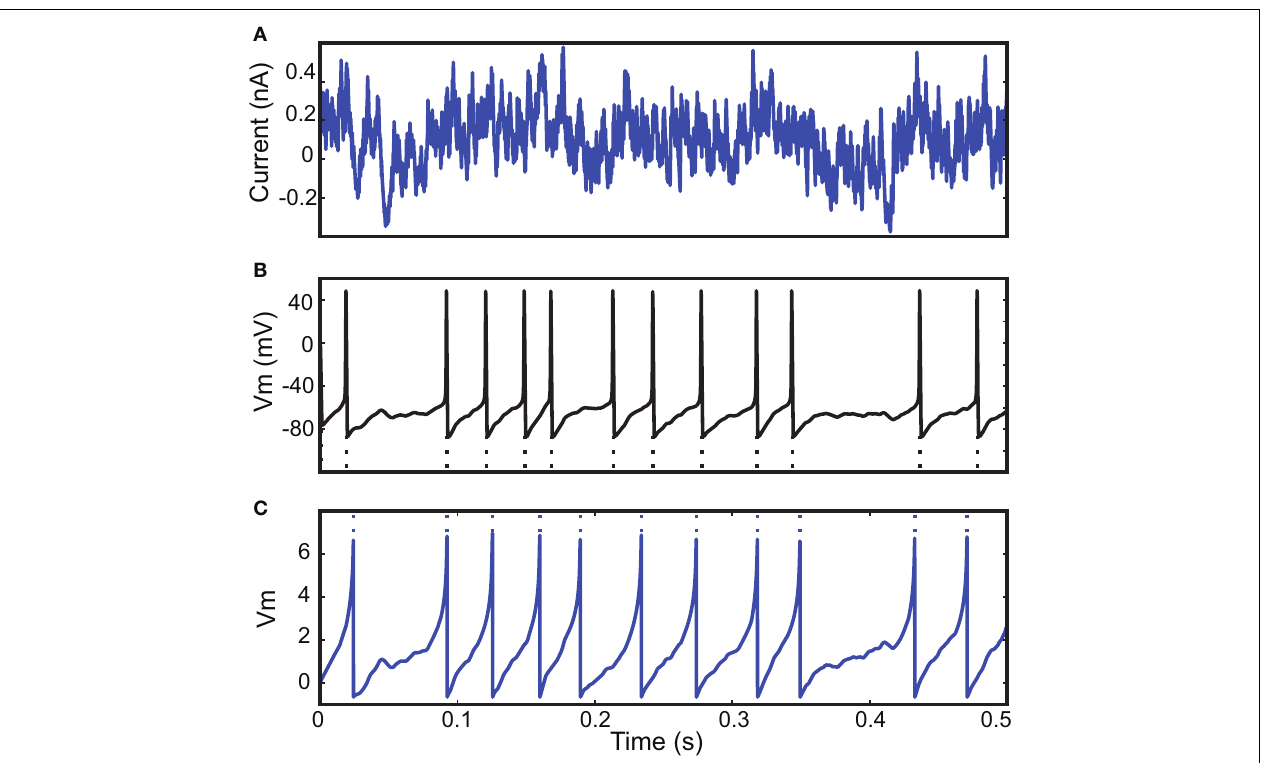
FIGURE 5 | Model reduction from a Hodgkin − Huxley model to an adaptive exponential integrate-and-fi re model (AdEx). (A) A 500-ms fl uctuating current is injected into a conductance-based model. (B) The output spike train is used to fi t